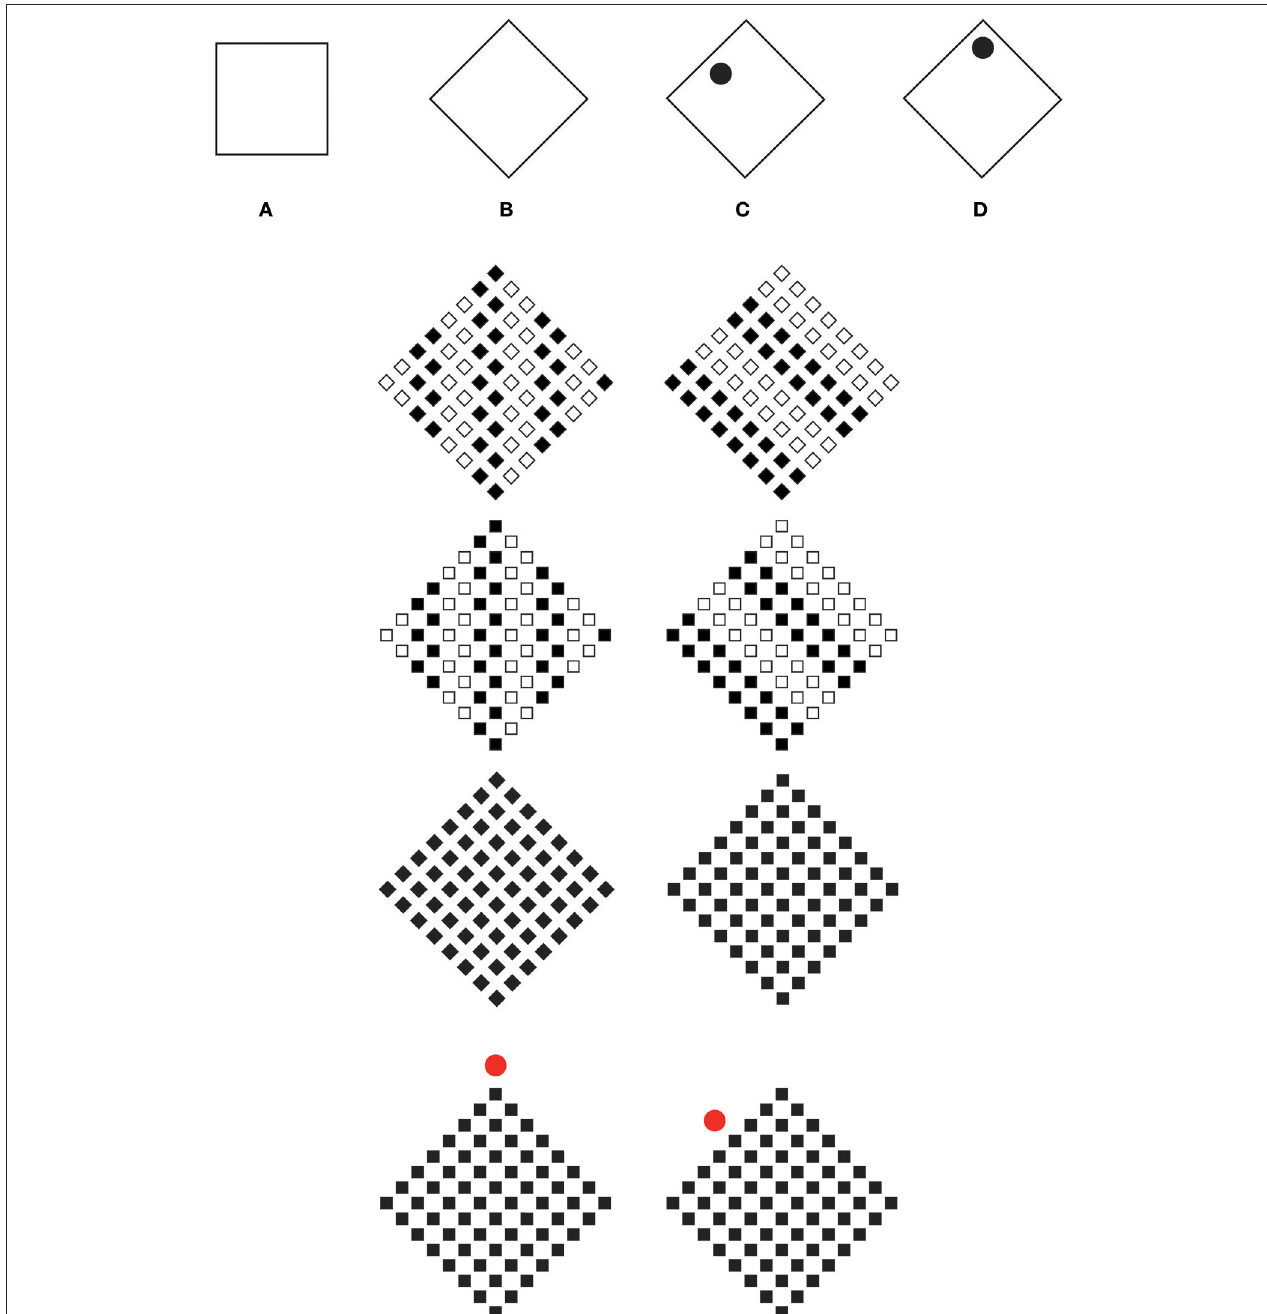
FIGURE 2 | Mach’s square/diamond illusion (A–B). “A rotated square” (C) and “a diamond” (D) .